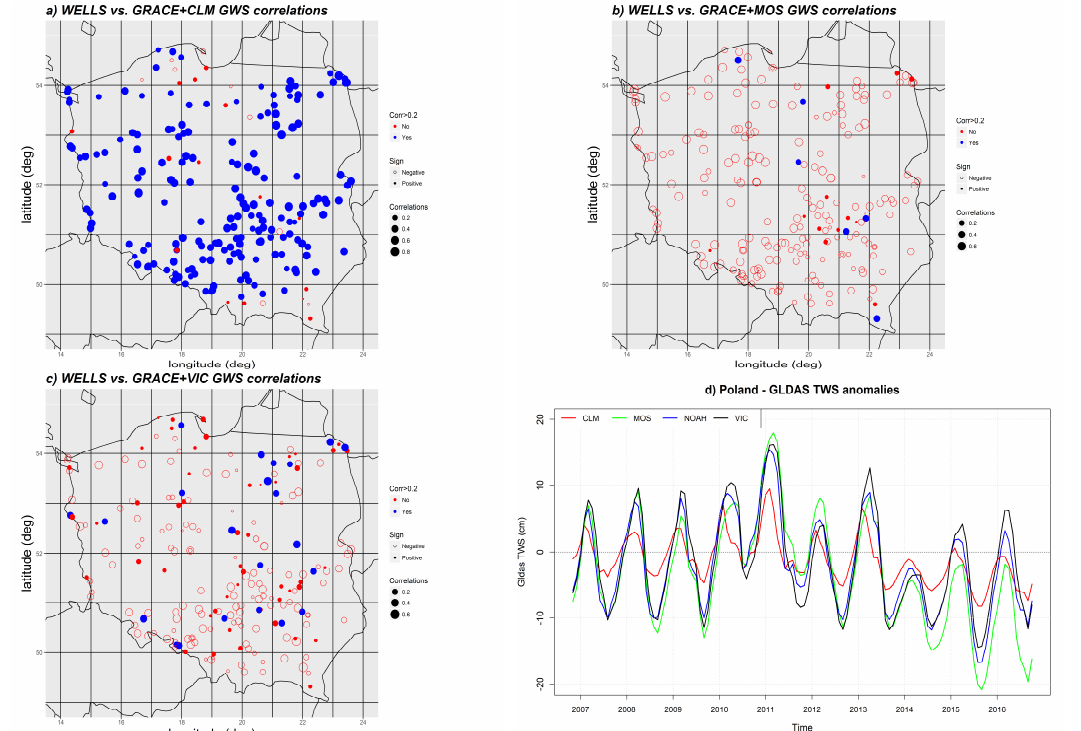
Figure 7. Correlations between the thickness of the unsaturated zone at the location of the well variations and GWS series obtained based on the community land model (CLM; a ), the mosaic (MOS; b ) and variable infiltration capacity (VIC; c ) models of global land data assimilation (GLDAS); ( d ) shows GLDAS TWS = soil moisture (SM) + snow water equivalent (SWE) + canopy (CA) from the four GLDAS